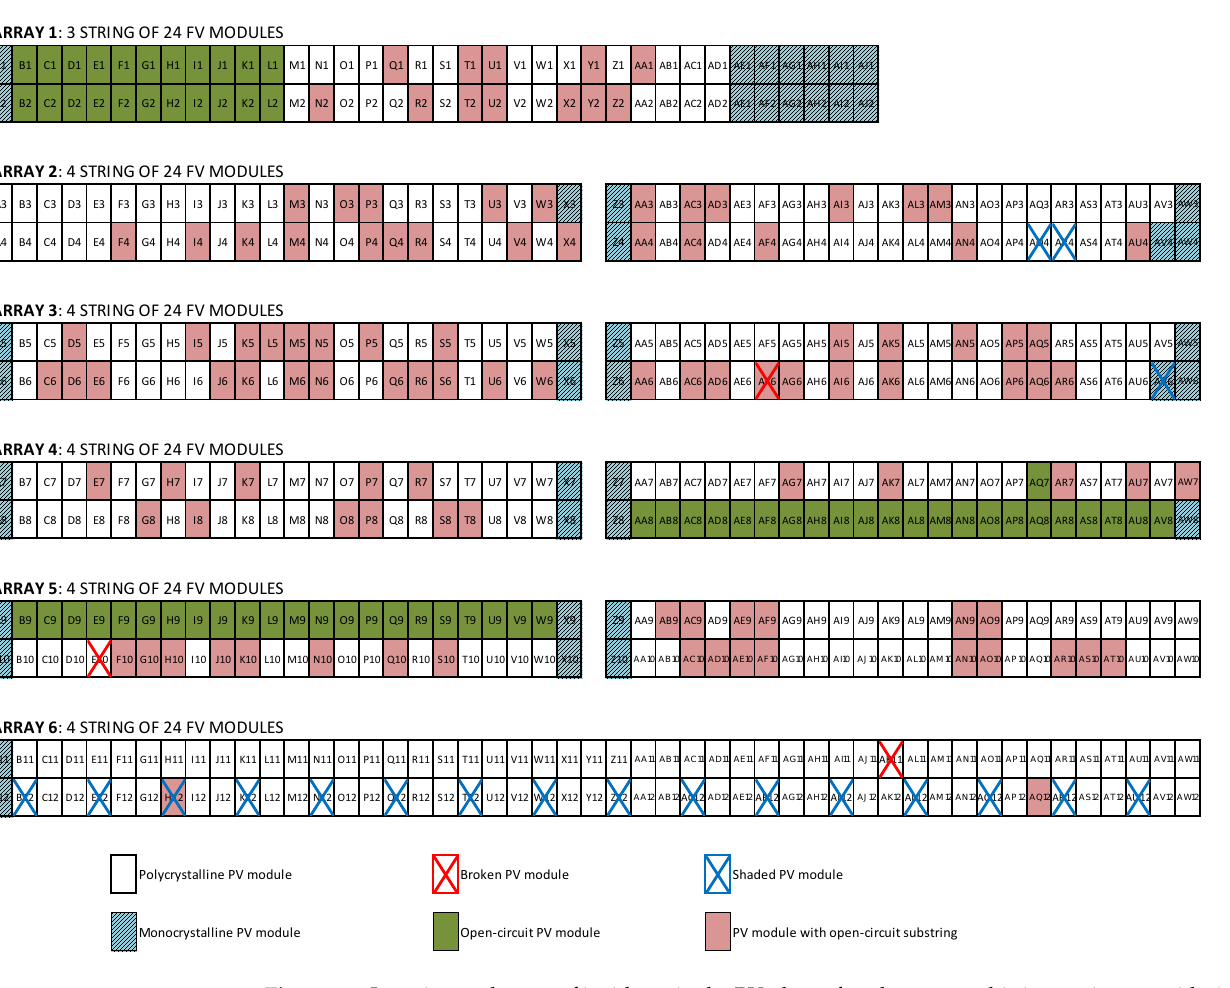
Figure 14. Location and types of incidents in the PV plant after thermographic inspection, considering the identification matrix of Figure 4a.